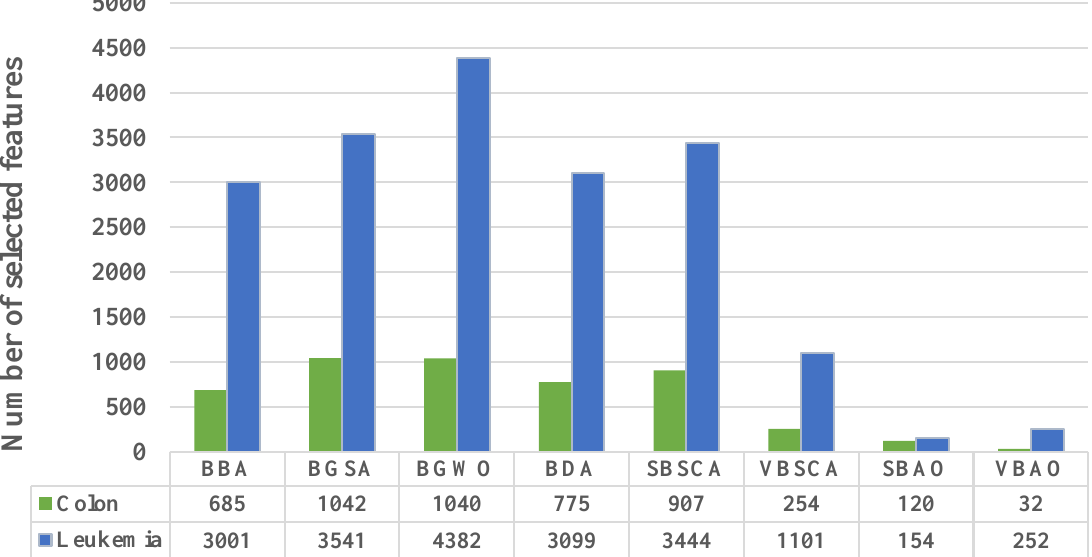
Figure 4. The Number of selected features comparison on large datasets.